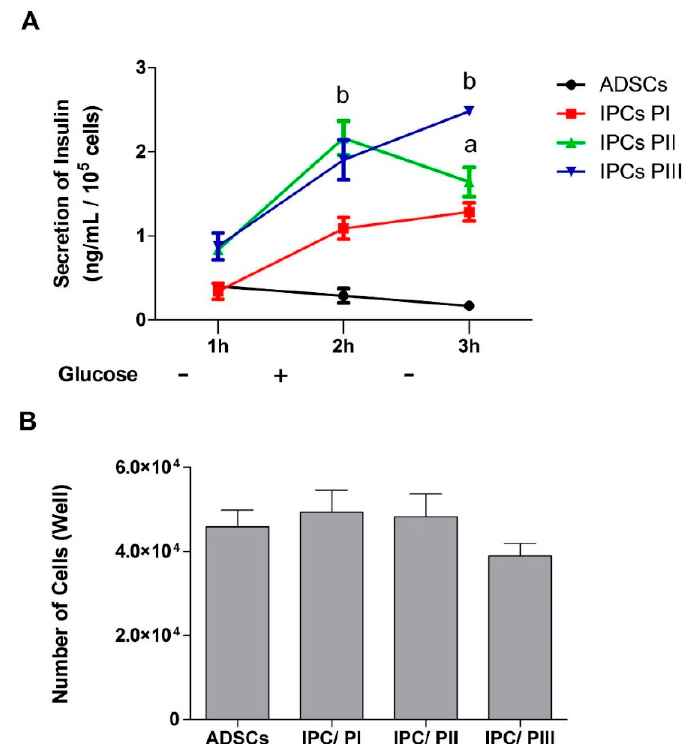
Figure 4. Insulin secretion by IPCs in response to glucose stimulation. ( A ) Insulin secretion curve in response to absence ( − ) or presence (+) of glucose (at 17.5 mM), as measured by ELISA. ( B ) Quantification of cells by the trypan blue exclusion method. The degree of cell integrity was determined by staining cells with Trypan blue. Stained cells were observed between 30 s and 2 min after the addition of Trypan blue using a Nikon Phase-contrast inverted light microscope at 100× magnification. In each sample, two fields of 100 cells were counted and the mean percentage of stained permeabilized cells was calculated. Data are expressed as means ± SE of 6 independent experiments performed in triplicate. Letters indicate different statistical groups in relation to undifferentiated ADSCs by repeated measures ANOVA ( A ) or one-way ANOVA ( B ) followed by Tukey’s test, assuming p < 0.05.